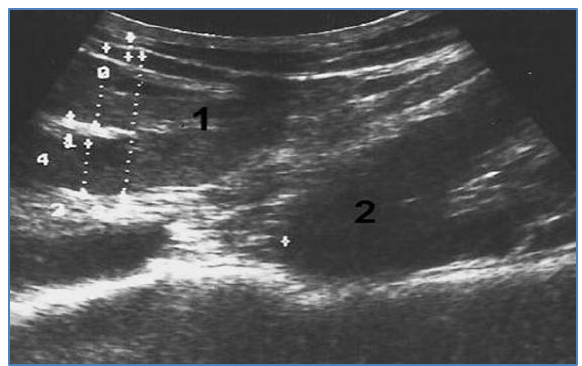
Figure, 3: Percutaneous ultrasonogram of both kidneys in right sublumbar fossa region of buffaloes. 3.5 MHz. 1=left kidney, 2= right kidney.